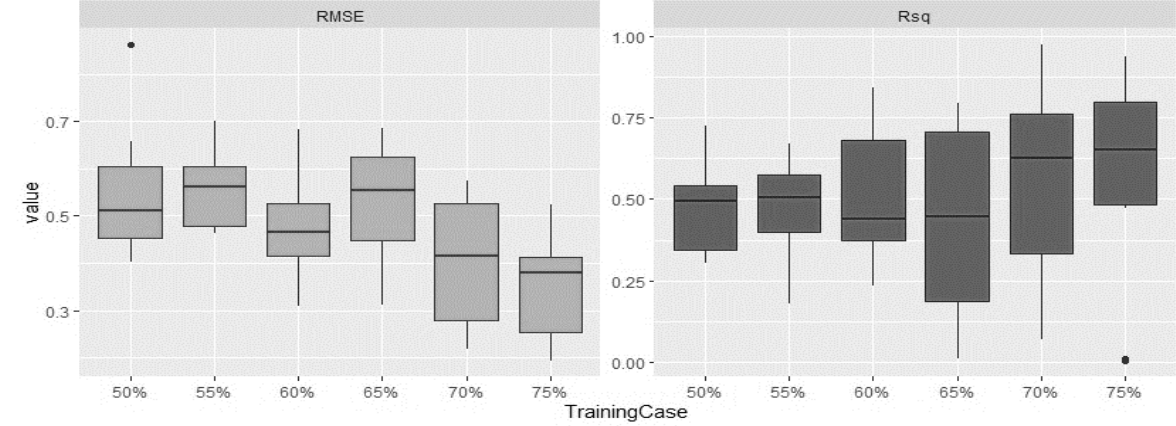
Figure 6. Model cross-validation test. The model improves if the RMSE value is close to 0 and the R 2 is close to 1.